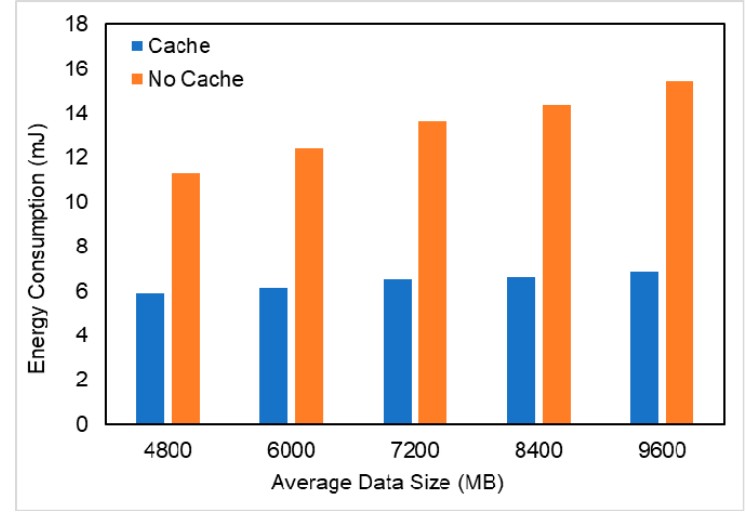
Figure 5. Energy consumption as the average size of data transmission increases when two strategies are adopted.